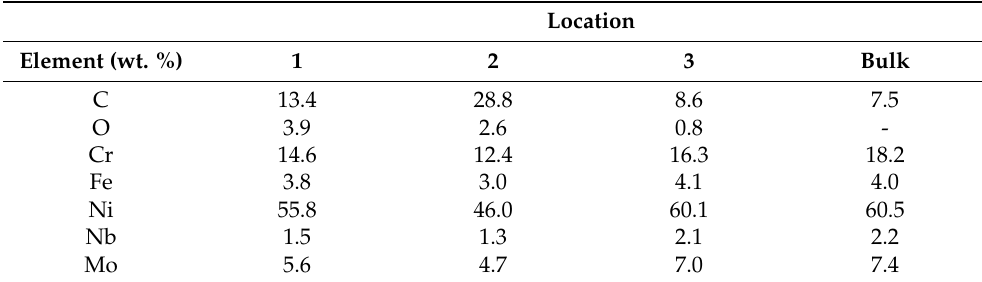
Table 8. EDX elemental analysis of locations shown in Figure 13. For comparison, an analysis of the bulk material after exposure at Chaunoy is included.